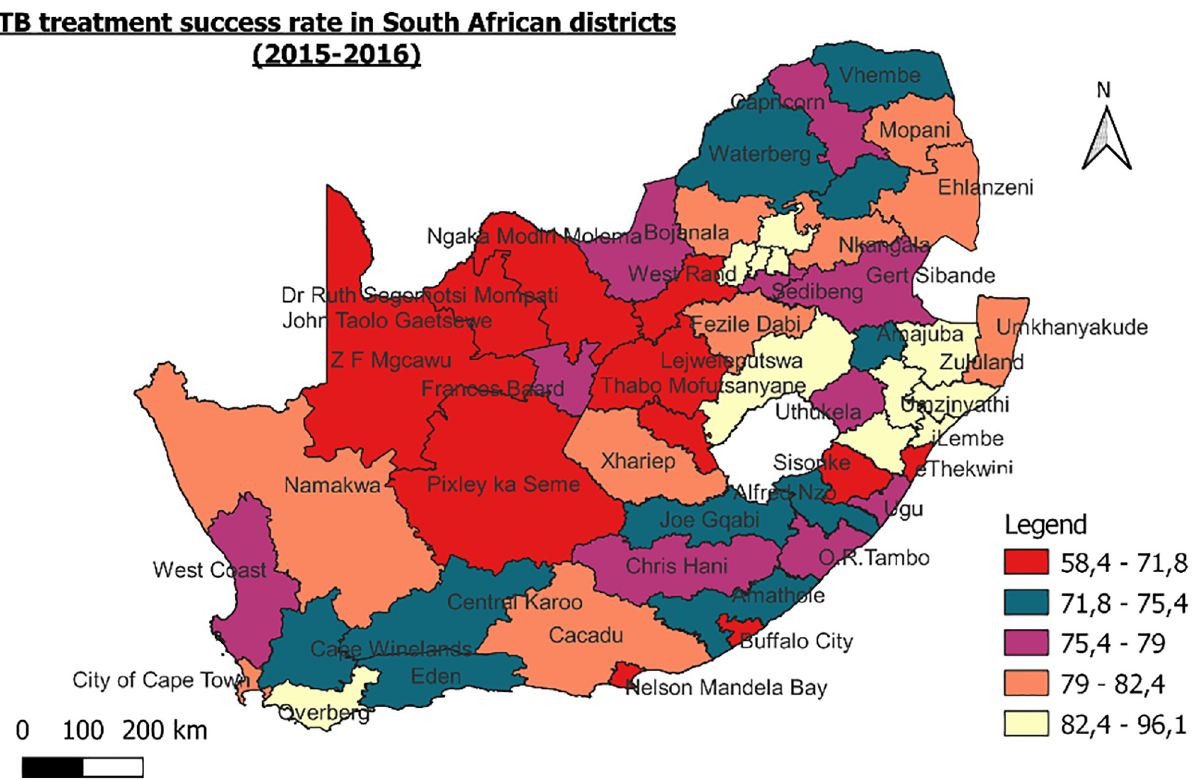
Fig 1. TB treatment success rate in South African